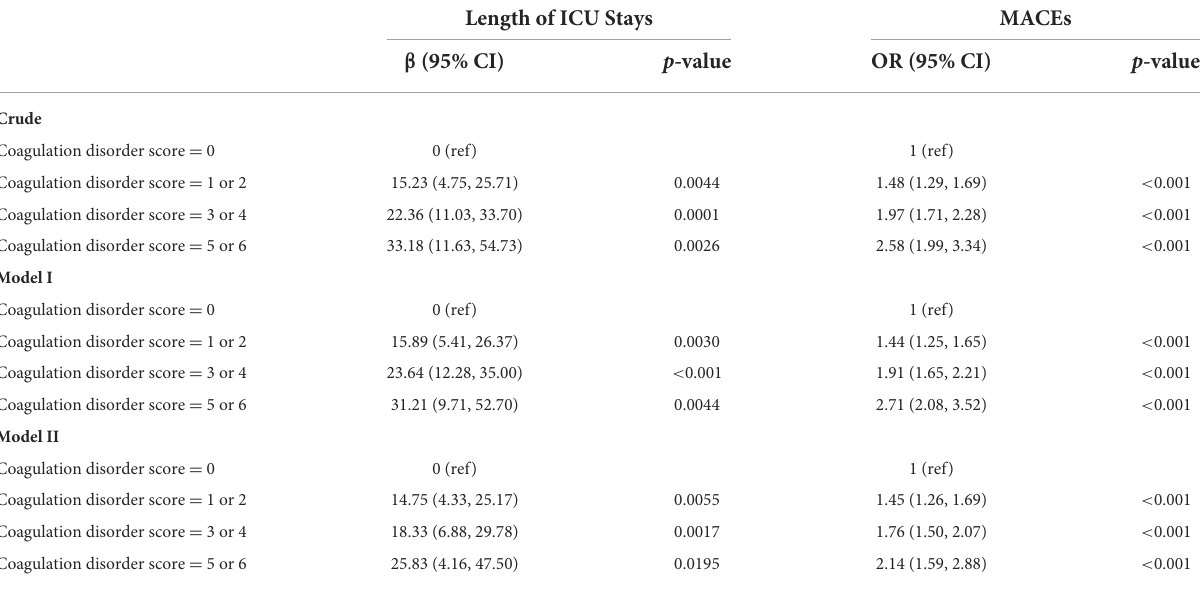
TABLE 4 The linear and logistic regression analysis of the coagulation disorder score for predicting the length of ICU stays and MACEs in critically ill patients with CHF, respectively. Length of ICU